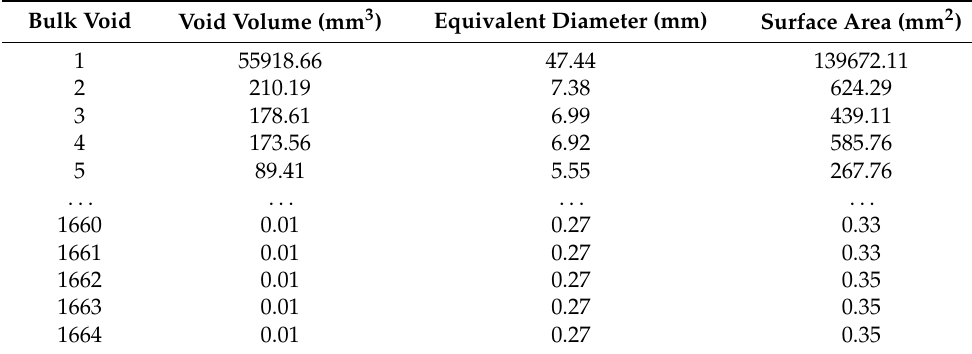
Table 9. Characteristic parameters of bulk voids in EPA-13 with 4.7% asphalt content.